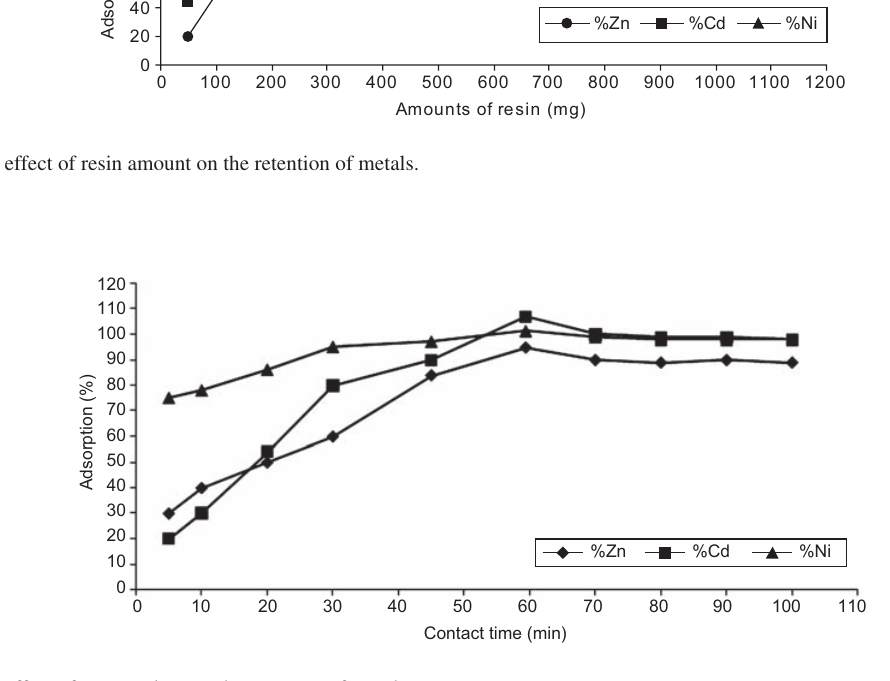
Figure 3 The effect of contact time on the recovery of